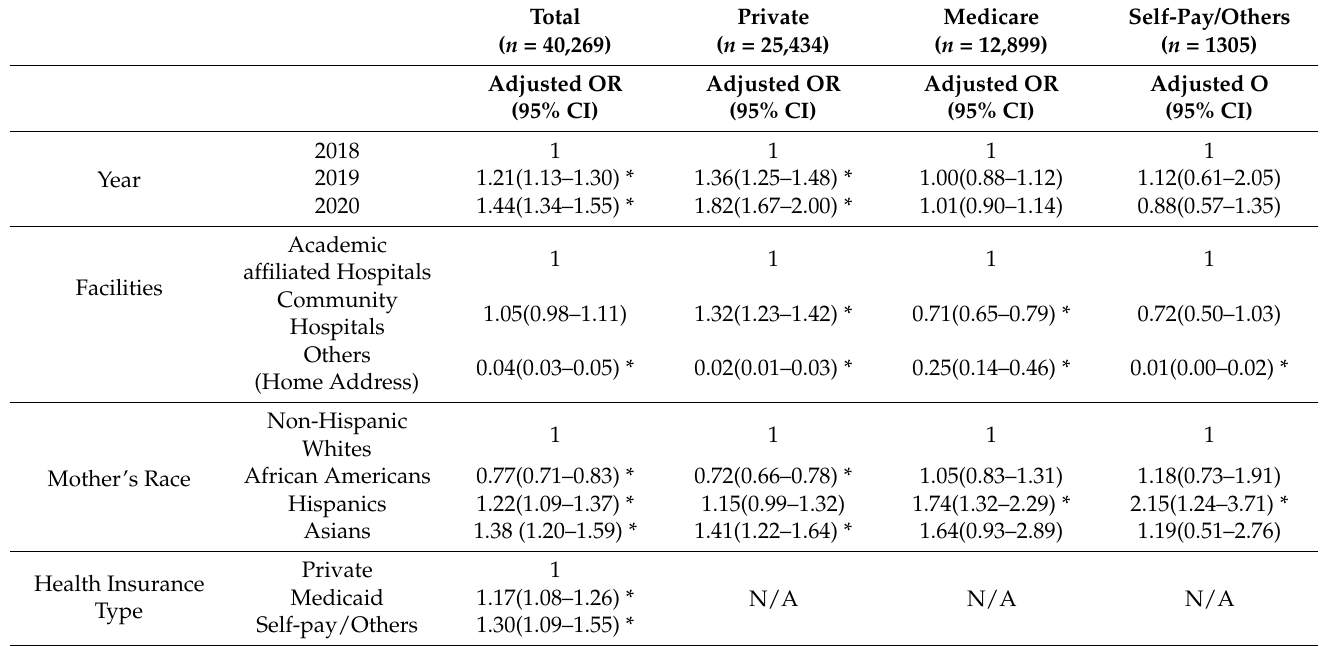
Table 3. Multivariable logistic regression of HepB birth dose: by health insurance type. Total Private Medicare ( n = 40,269) ( n = 25,434) ( n = 12,899) ( n =